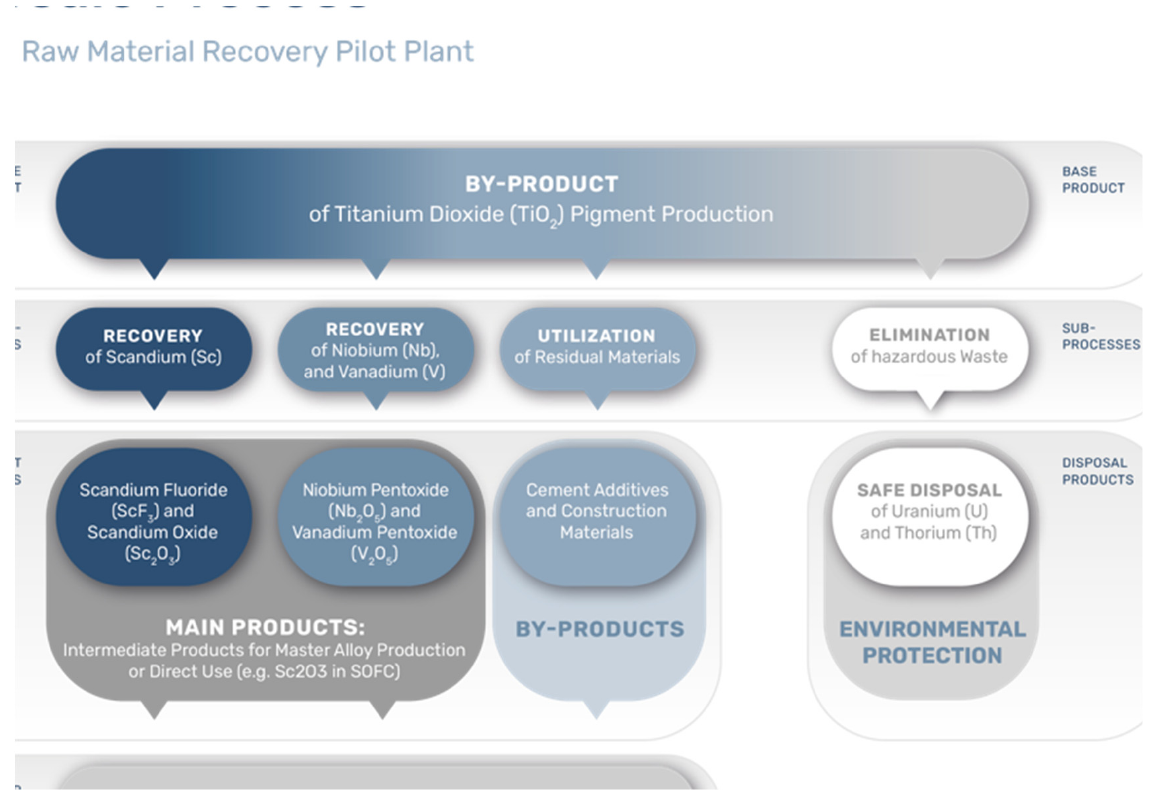
Figure 2. Zero-waste ScaVanger concept.